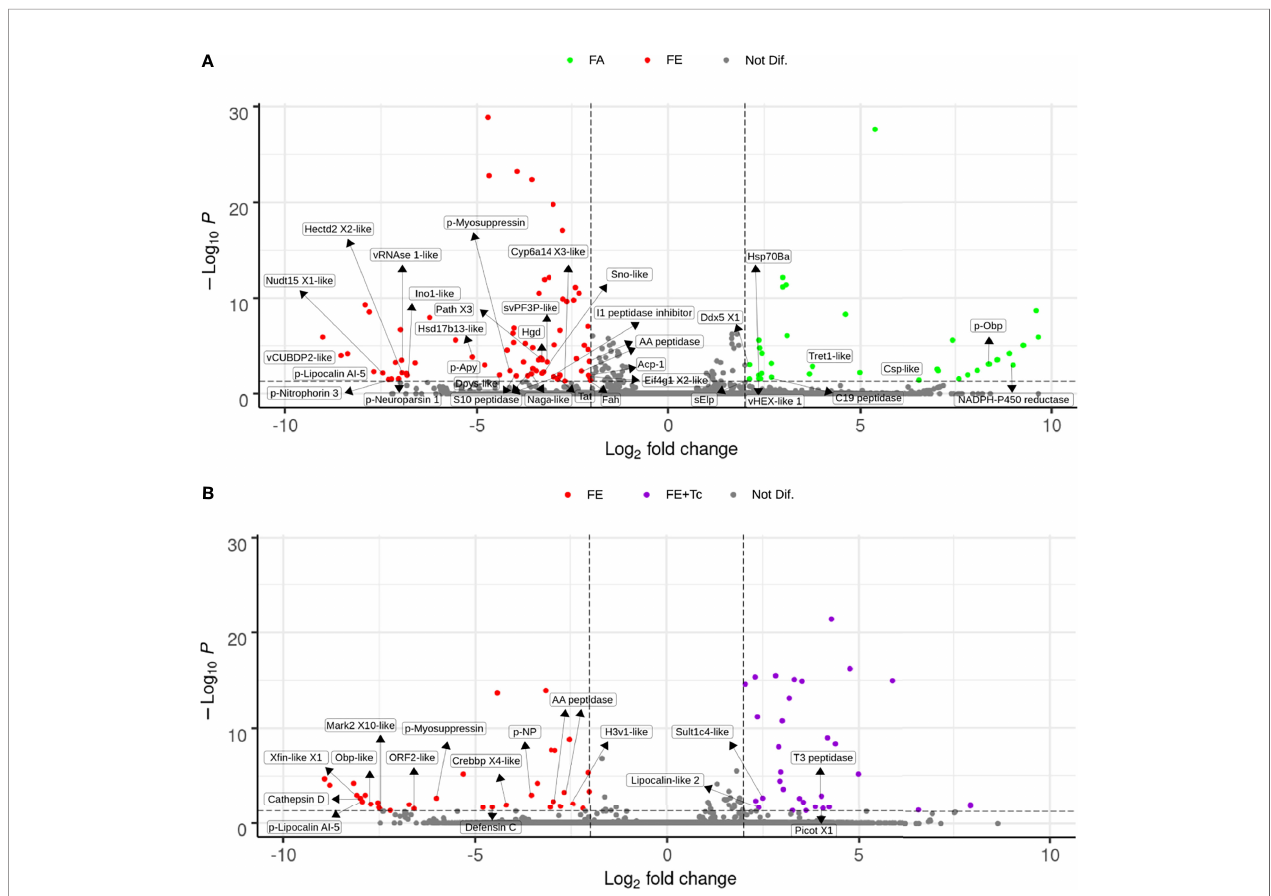
FIGURE 9 | Differential expression of individual transcripts in the intestine according to blood supply and T. cruzi infection. (A) Volcano Plot of transcriptional expression in the intestine of fasted vs. fed R. neglectus . (B) Volcano Plot of transcriptional expression in the intestine of fed uninfected vs. fed infected R. neglectus . *Dots not assigned: unknown/hypothetical proteins. *padj < 0.05 (-Log 10 P < 50 -3 ); Log 2 fold change < -2 or > 2. *-like: transcript similar to sequence previously determined as similar to segment translated into a respective protein. *AA peptidase: subfamily AA unassigned peptidase; Acp-1: acid phosphatase-1; C19 peptidase: family C19 unassigned peptidase; Cathepsin D: cathepsin D; Crebbp X4-like: CREB-binding protein isoform X4; Csp-like: chemosensory protein; Cyp6a14 X3-like: cytochrome P450 6a14 isoform X3; Ddx5 X1: ATP-dependent RNA helicase DDX5 isoform X1; Dpys-like: dihydropyrimidinase; Eif4g1X2-like: eukaryotic translation initiation factor 4 gamma 1 isoform X2; Fah: fumarylacetoacetase; H3v1-like: histone H3v1; Hectd2 X2-like: E3 ubiquitin-protein ligase HECTD2 isoform X2; Hgd: homogentisate 1,2-dioxygenase; Hsd17b13-like: 17-beta-hydroxysteroid dehydrogenase 13; Hsp70Ba: major heat shock 70 kDa protein Ba; I1 peptidase inhibitor: family I1 unassigned peptidase inhibitor; Isyna-like: inositol-3-phosphate synthase; Lipocalin-like 2: lipocalin protein 2; Mark2 X10-like: serine/ threonine-protein kinase MARK2 isoform X10; Naga-like: Alpha-N-acetylgalactosaminidase; Nudt15 X1: nucleotide triphosphate diphosphatase NUDT15 isoform X1; Obp-like: odorant-binding protein; p-Apy: 79 kDa salivary apyrase precursor; Path X3: proton-coupled amino acid transporter protein pathetic isoform X3; Picot X1: inorganic phosphate cotransporter isoform X1; p-Lipocalin AI-5: lipocalin AI-5 precursor; p-Myosuppressin: myosuppressin precursor; p-Neuroparsin 1: neuroparsin 1 precursor; p-Nitrophorin-3: Nitrophorin-3 precursor; p-NP: nonstructural protein precursor; p-Obp: odorant-binding protein precursor S10 peptidase: family S10 unassigned peptidase; sElp: secreted Esterase/lipase protein; Sno-like: senecionine N-oxygenase; Sult1c4-like: sulfotransferase 1C4; svPF3P-like: secreted venom protein family 3 protein; T3 peptidase: family T3 unassigned peptidase; Tat: tyrosine aminotransferase; Tret1-like: facilitated trehalose transporter Tret1; vCUBDP2- like: venom CUB domain protein 2; vHEX-like 1: venom hexamerin protein 1; vRNase1-like: venom ribonuclease 1; X fi n-like X1: zinc fi nger protein X fi n-isoform